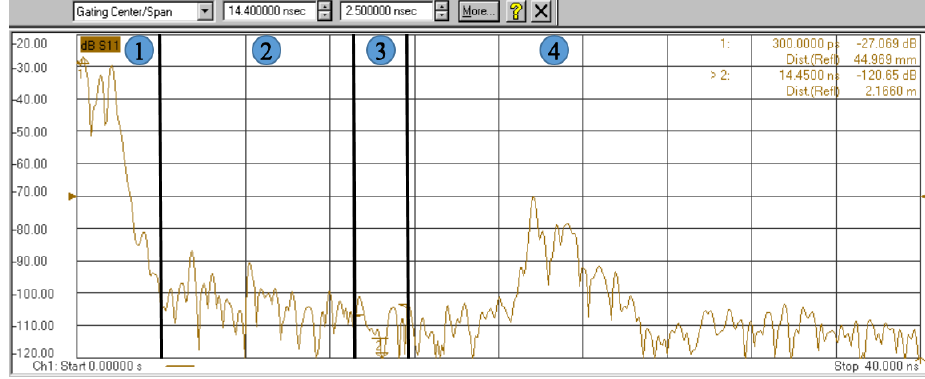
Fig. 6. The time domain plot for the reflection signal in laboratory bench without the research object, horizontal